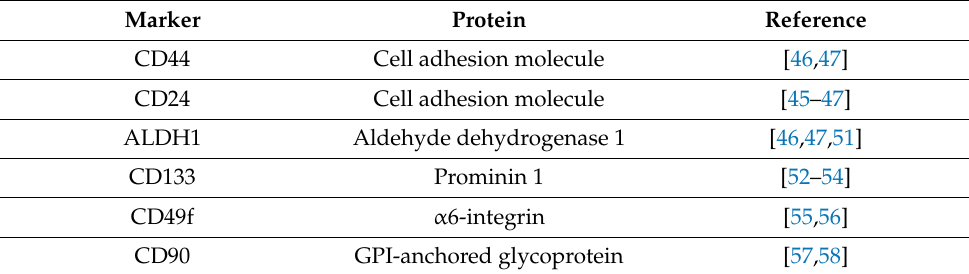
Table 1. Stem cells markers used for the bCSC designation and